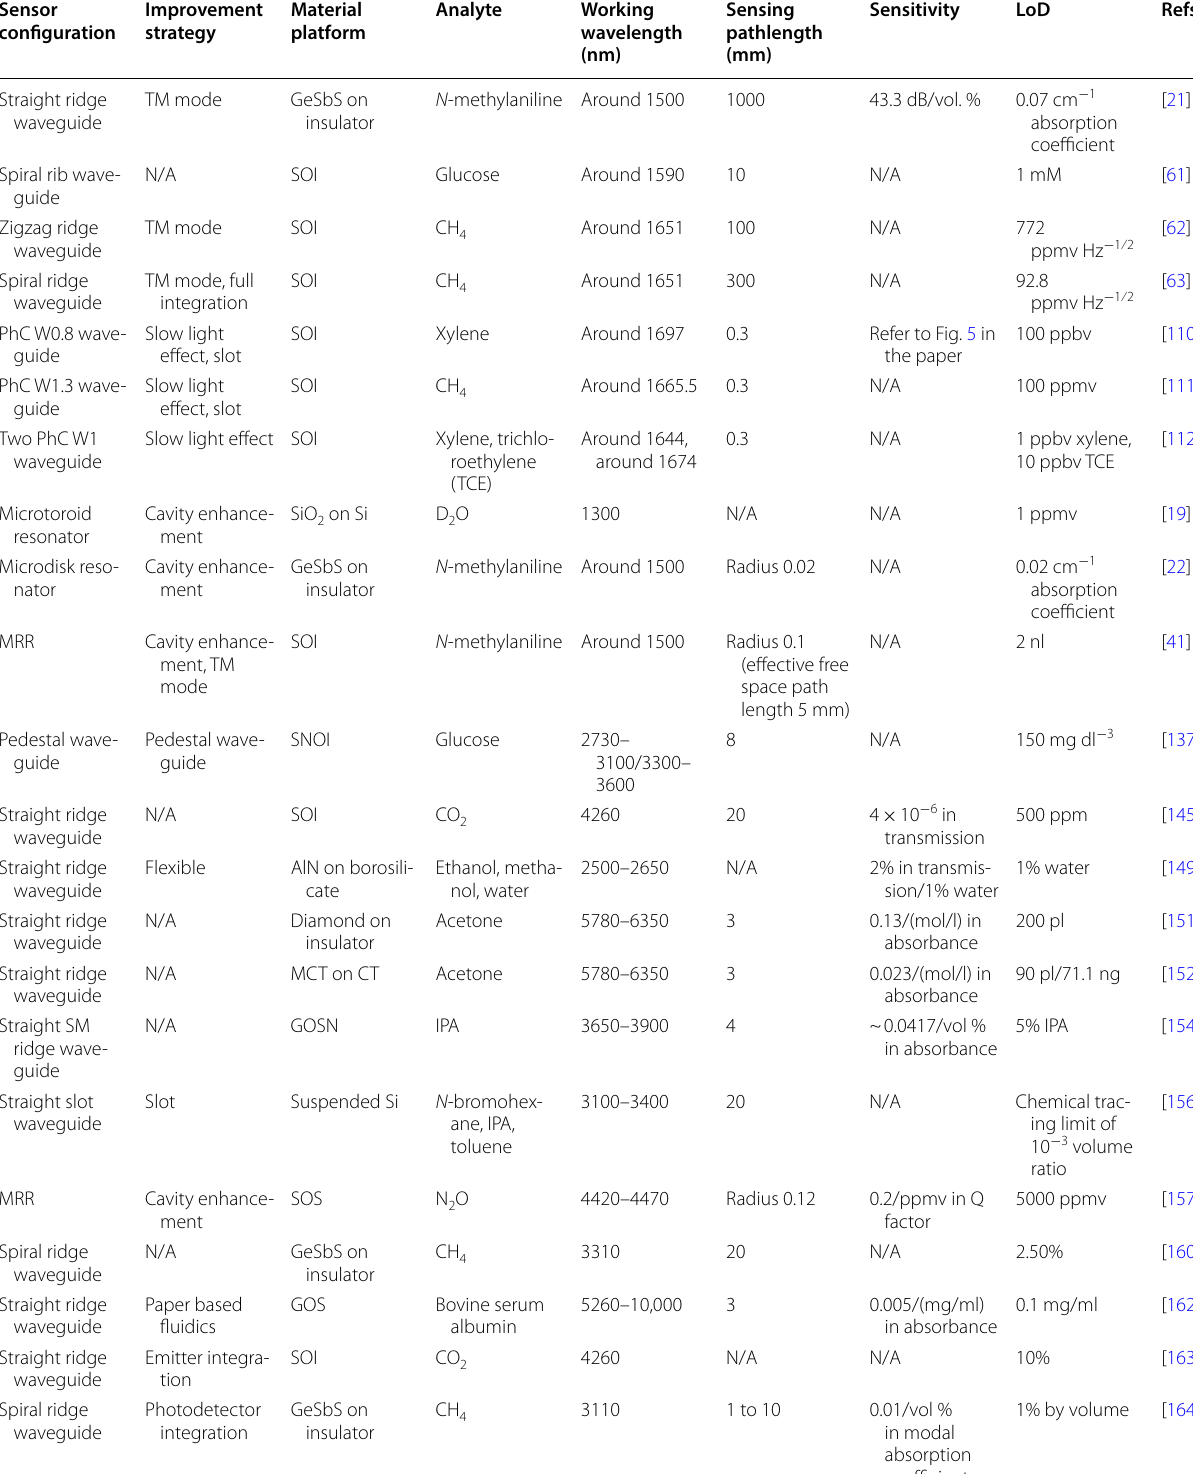
Table 2 Summary of representative absorption‑based infrared guided‑wave nanophotonic biochemical sensors Sensor